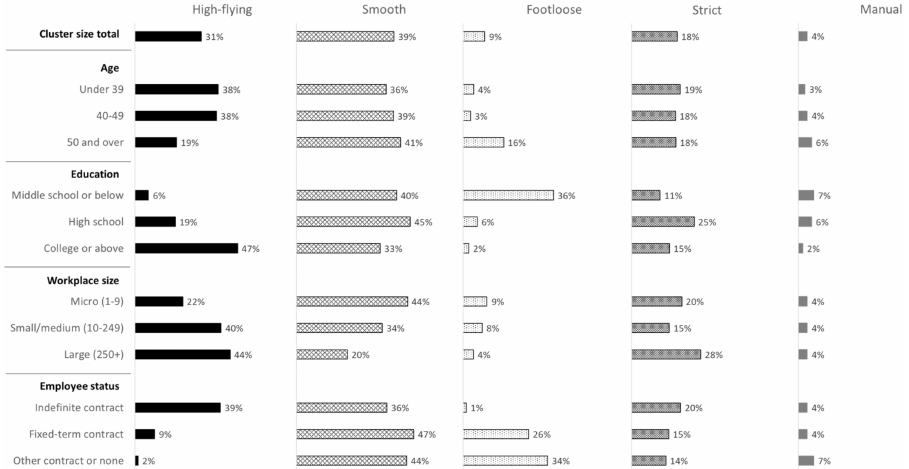
Figure 3. Job quality profiles by demographic characteristics (% of employees in each